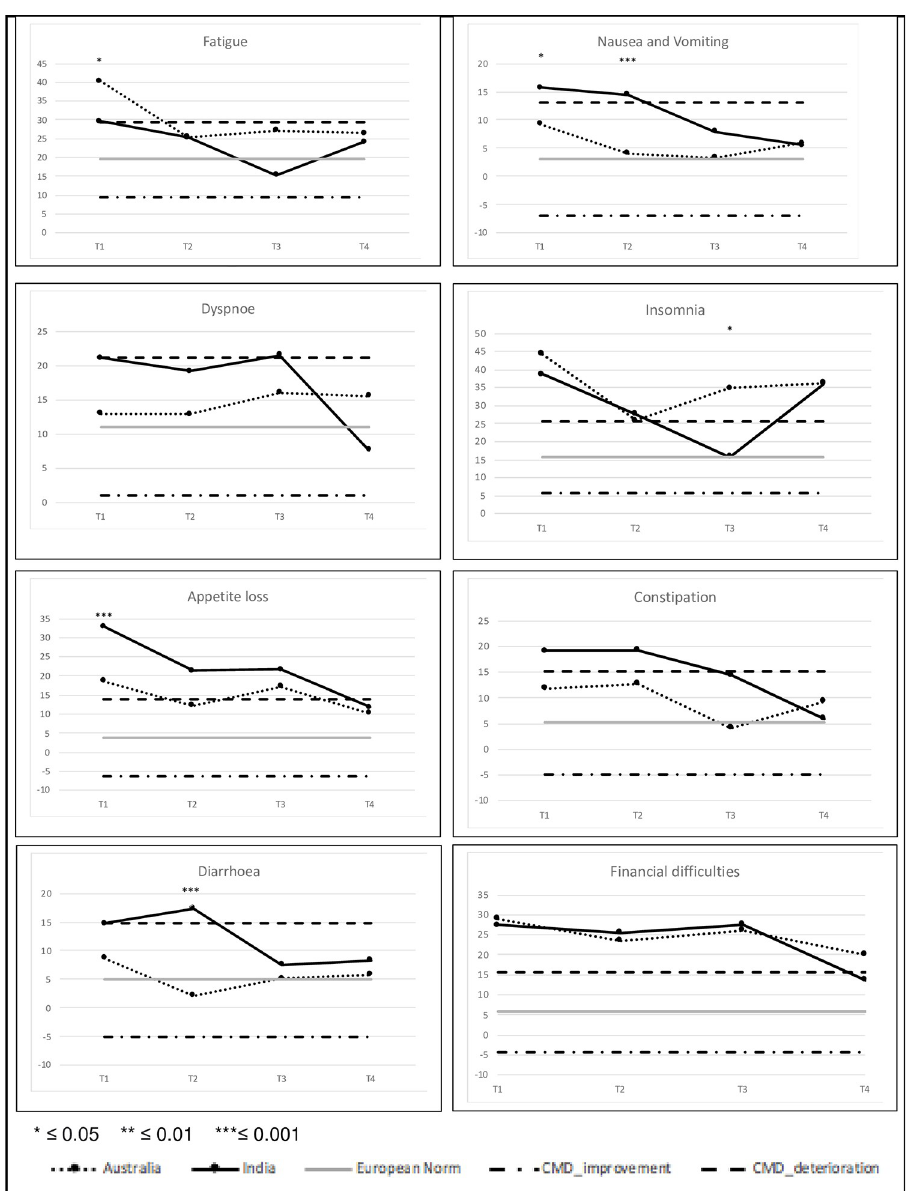
Fig 2. QLQ-C30 symptom scales and clinically meaningful difference (CMD) to the European normative population.